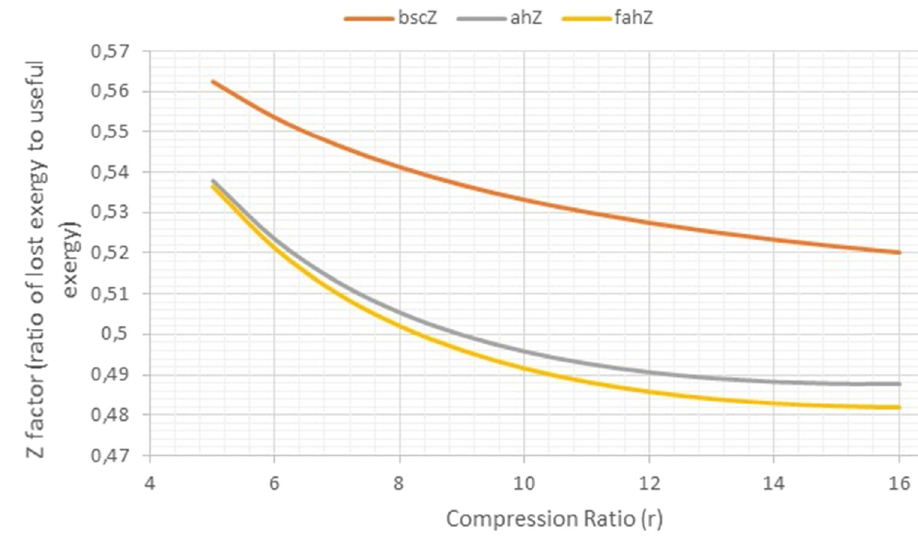
Figure 5: Variation of the Z factor with the compression ratio ( r ) for bsc, ah and fah cogeneration systems.